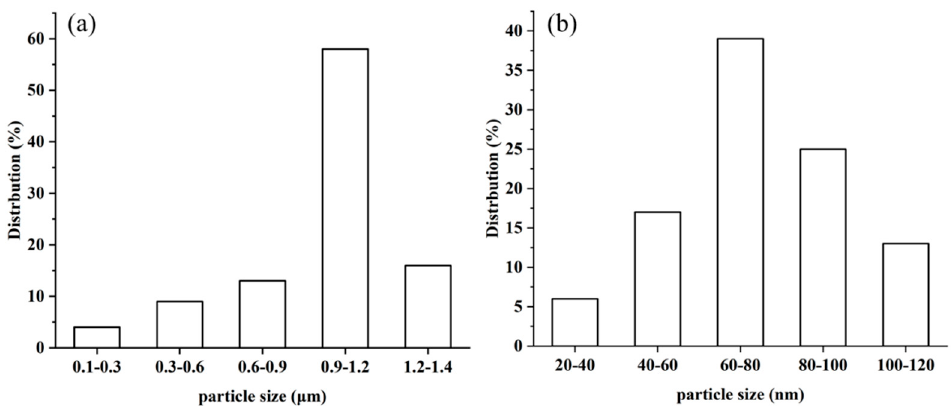
Figure 5. The particle size distribution of MA ( a ) and MC ( b ).